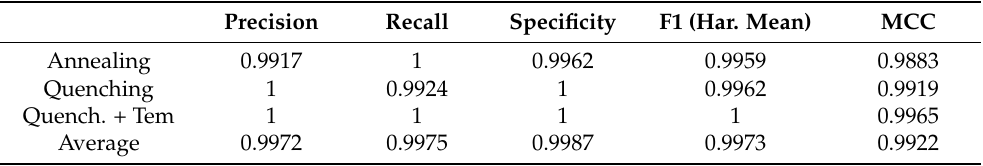
Table 5. Indicators that define the behavior of pre-trained deep-learning network ResNet50; FP/FN = false positives/false negatives; and TP/TN = true positives/negatives. These values were obtained from samples not used for training and/or validating the network.